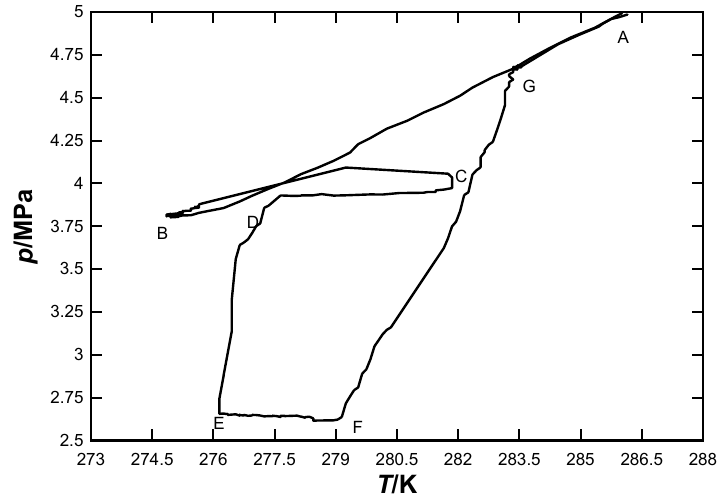
Figure 2. Typical p-T curves for CO beads with uniform pore size